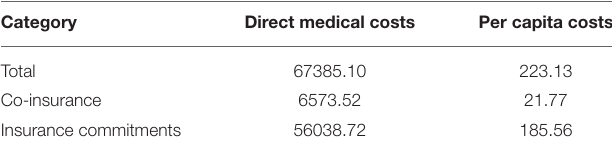
TABLE 2 | Direct medical costs of the poisoning treatment in Kermanshah province, Iran (obtained from medical records $).